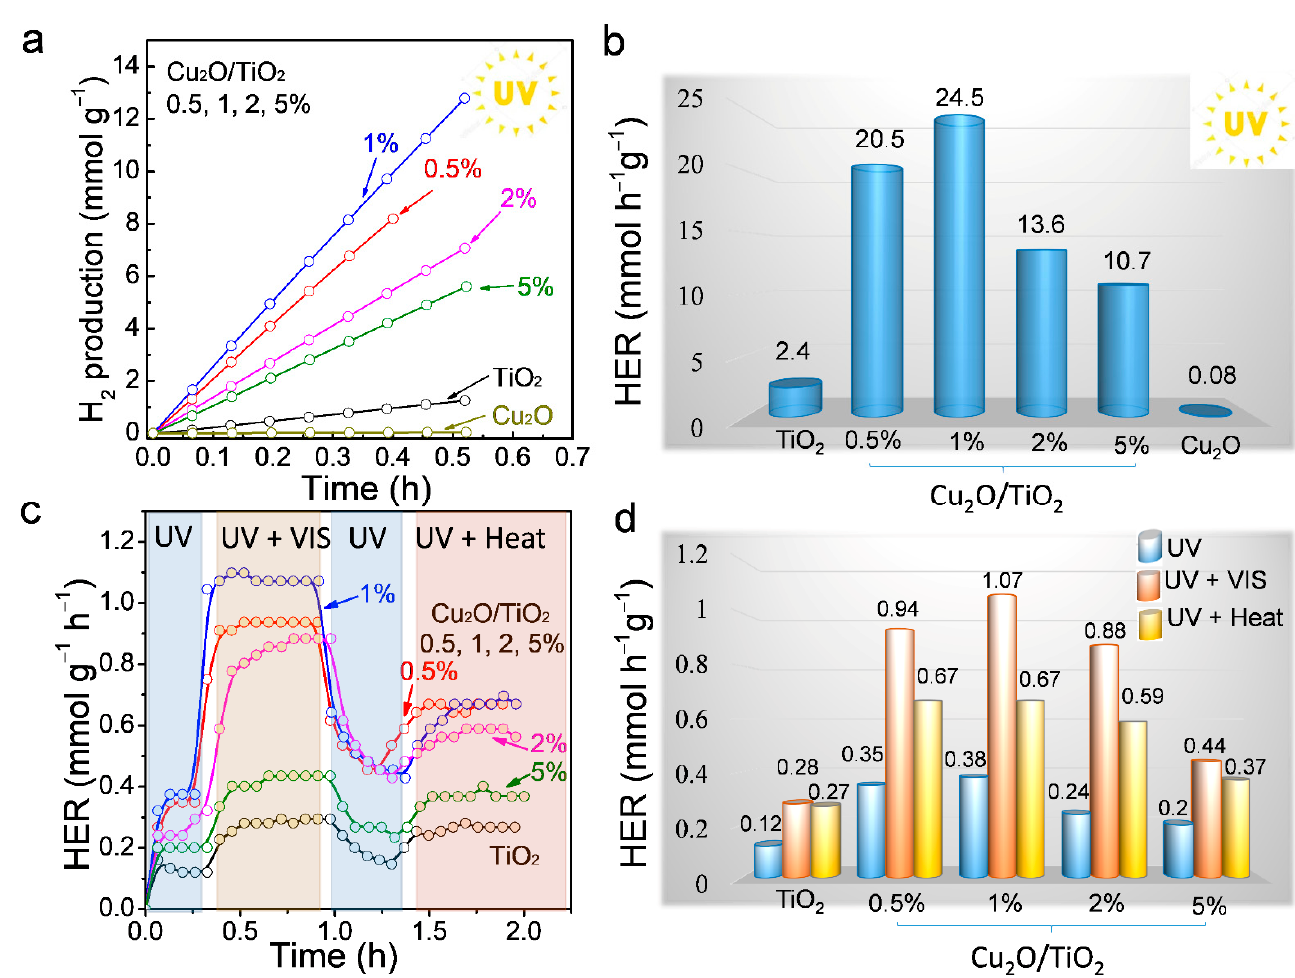
Figure 3. ( a ) Photocatalytic H 2 evolution on TiO 2 , Cu 2 O, 0.5%, 1%, 2% and 5% Cu 2 O/TiO 2 nanocomposites under UV light irradiation (365 ± 5 nm and 79.1 ± 0.5 mW·cm − 2 ). ( b ) HER from data displayed in panel ( a ). ( c ) HER measured on TiO 2 , 0.5%, 1%, 2% and 5% Cu 2 O/TiO 2 nanocomposites under different conditions: (1) UV light irradiation (372 ± 5 nm and 11.2 ± 0.5 mW·cm − 2 ), (2) UV (372 ± 5 nm and 11.2 ± 0.5 mW·cm − 2 ) plus visible light irradiation (0.017 ± 0.005 mW·cm − 2 ), (3) UV light irradiation and (4) UV light irradiation and heating to compensate for the temperature (~36 − 37 °C). ( d ) HER obtained from the data displayed in panel ( c ).